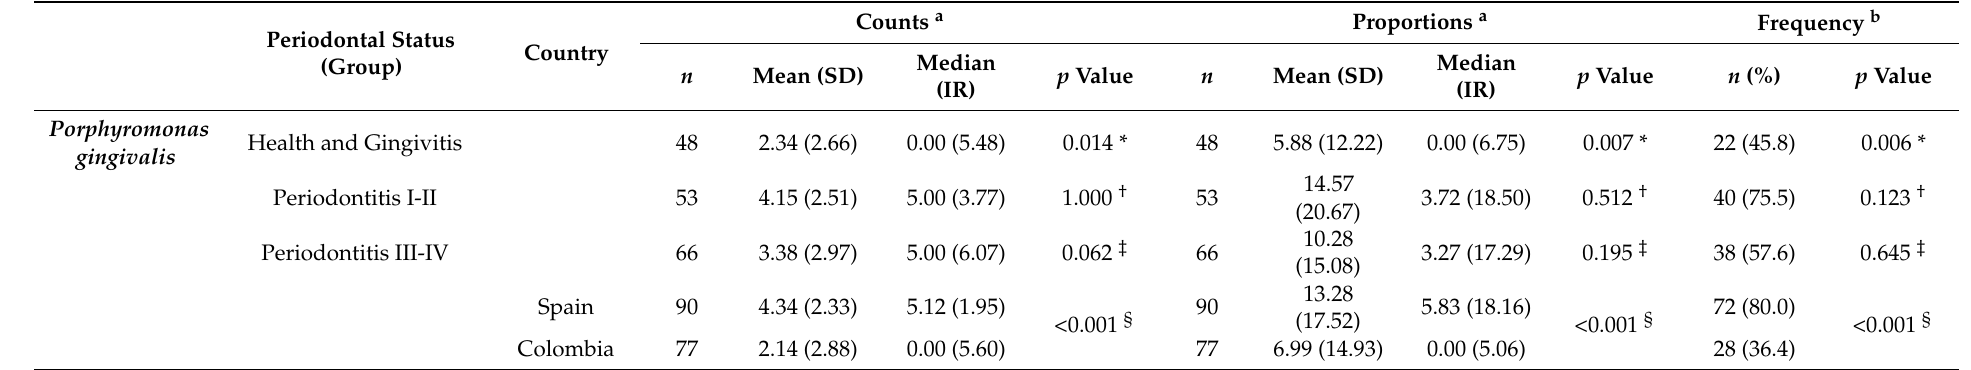
Table 5. Mean and standard deviation (SD) and median and interquartile range (IR) of counts (log transformed), proportions and frequencies of detection of target bacterial species according to periodontal status and country. Counts and proportions were calculated considering all